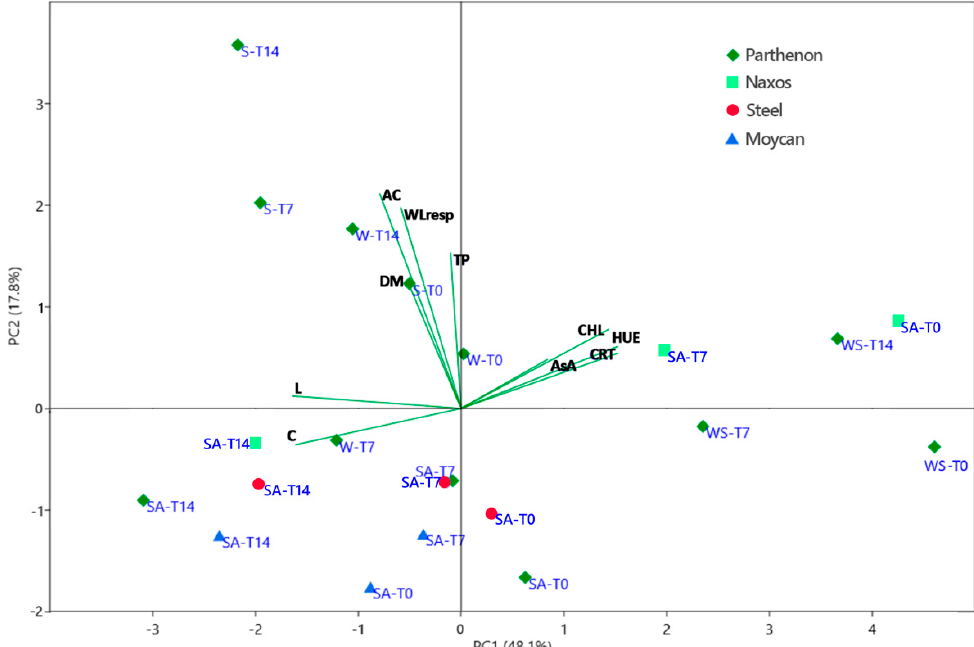
Figure 7 . Principal component analysis bi-plot (PC 1 vs PC 2) showing the spatial distribution of the main examined traits in raw (T 0 ), 7 (T 7 ) and 14 (T 14 ) days stored broccoli [namely: lightness index (L), hue angle (HUE), chroma (C), concentration of dry matter (DM), chlorophylls (CHL), carotenoids (CRTs), total phenols (TP), ascorbic acid (AsA), antioxidant capacity (AC), and losses of fresh weight by respiration (mass losses) (WLresp)], as affected by the growing period [summer–autumn (SA), winter (W), winter–-spring (WS), spring (S)] and